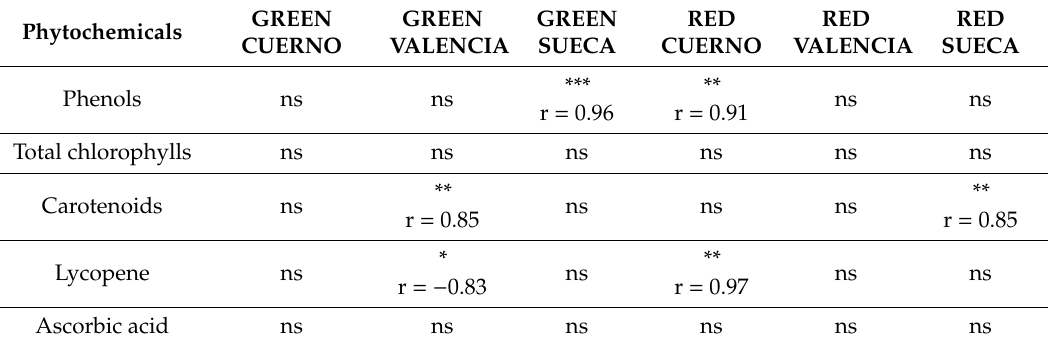
Table 3. Correlation coe ffi cients and their significance determined between each phytochemical and antioxidant capacity produced by the green and red fruit produced by the three landraces. Correlation coe ffi cient r is reported when the correlation was significant. ns: p > 0.05; *: p ≤ 0.05; **: p ≤ 0.01; ***: p ≤